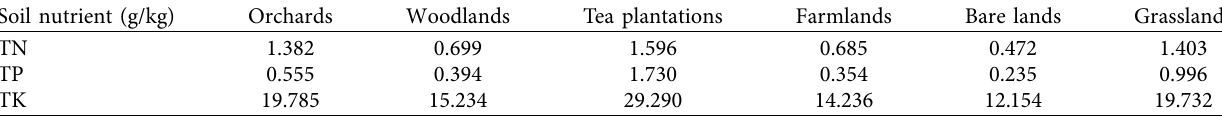
Table 2: The average contents of soil samples total carbon, total phosphorus, and total potassium.